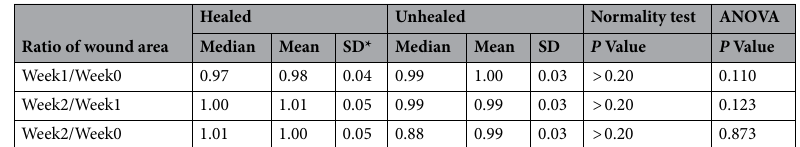
Table 3. One way ANOVA—comparison between ratio of the ulcer areas of thermal images across three weeks and the healing status at week 12. *Standard deviation from the mean.